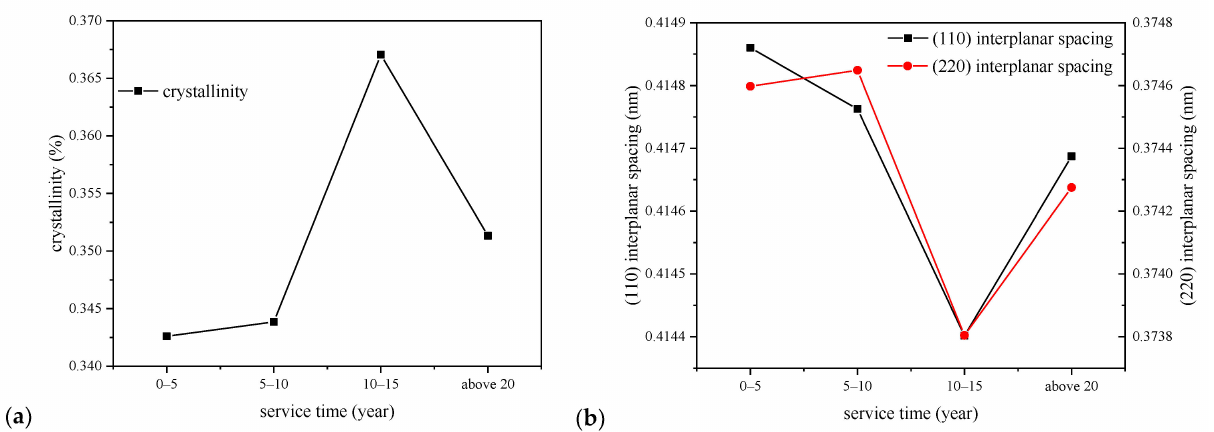
Figure 4. The characteristic parameters of the crystal structure of XLPE films with the service years. ( a ) crystallinity; ( b ) interplanar spacing of each crystal